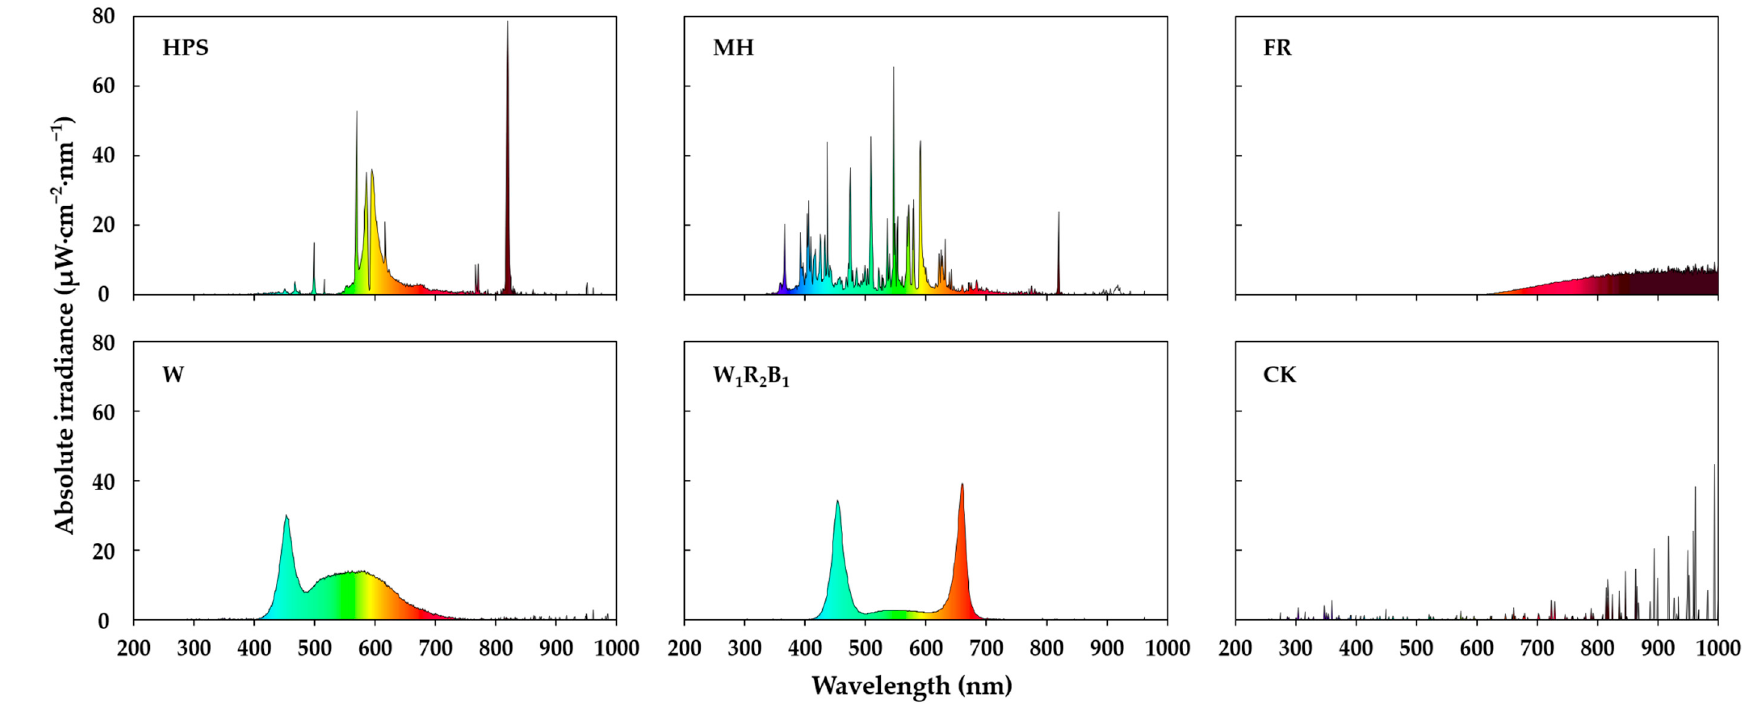
Figure 2. Spectral qualities of the different supplementary light sources used in the experiment. HPS (high-pressure sodium), MH (metal halide), FR (far-red), W (white LEDs), W 1 R 2 B 1 (mixed LEDs), and CK (control).